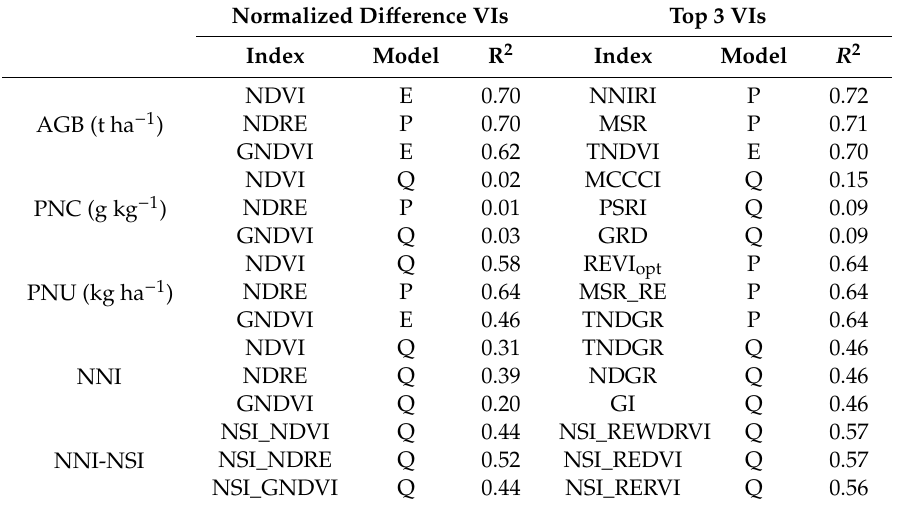
Table 2. Coe ffi cient of determination (R 2 ) for relationships between normalized di ff erence vegetation indices (VIs) and the top three VIs calculated from unmanned aerial vehicle (UAV) remote sensing and aboveground biomass (AGB), plant nitrogen concentration (PNC), and plant nitrogen uptake (PNU) and relationships between vegetation indices and nitrogen su ffi ciency index (NSI) calculated from vegetation indices and nitrogen nutrition index (NNI) across varieties and